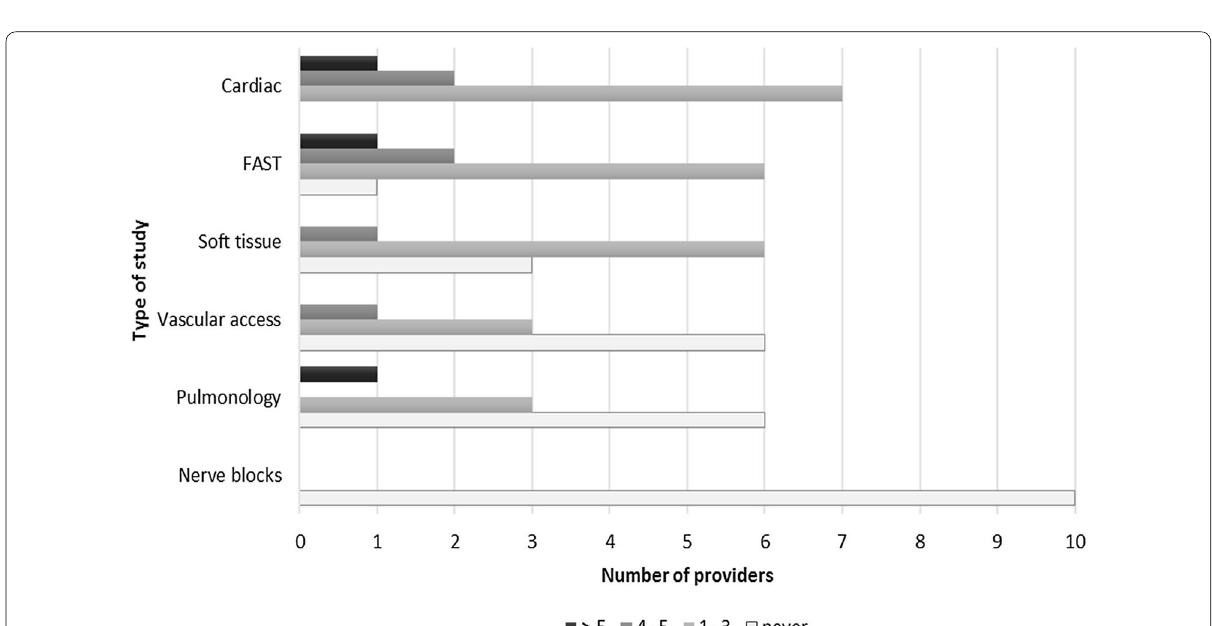
Fig. 2 Provider confidence in ultrasonography of the various types of studies